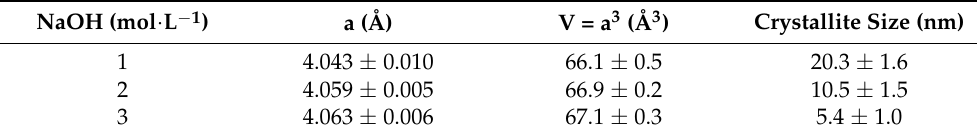
Figure 7. XRD patterns of samples prepared under different NaOH concentrations. Table 2. The lattice parameter, cell volume, and crystallite size of the samples, prepared at different NaOH concentrations.